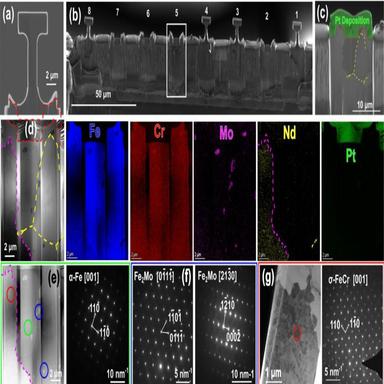
TEM characterization of HT9_005_base specimen. (a)–(c) SEM images illustrate where the TEM foil (d) was extracted. (d) STEM BF image together with the STEM-EDS mapping of selective elements with observable distribution variation over the scanned area. (e)–(g) Diffraction patterns of selected areas as highlighted in (e).